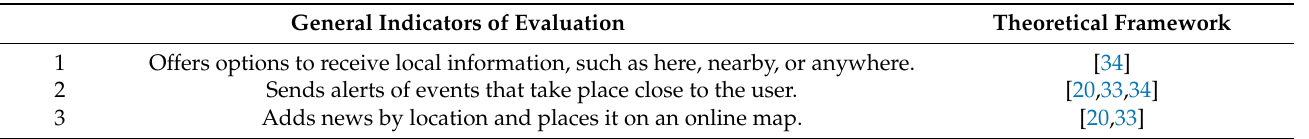
Table 1. How do Portuguese local journalists use the geolocation tools to provide local news via mobile apps? General Indicators of